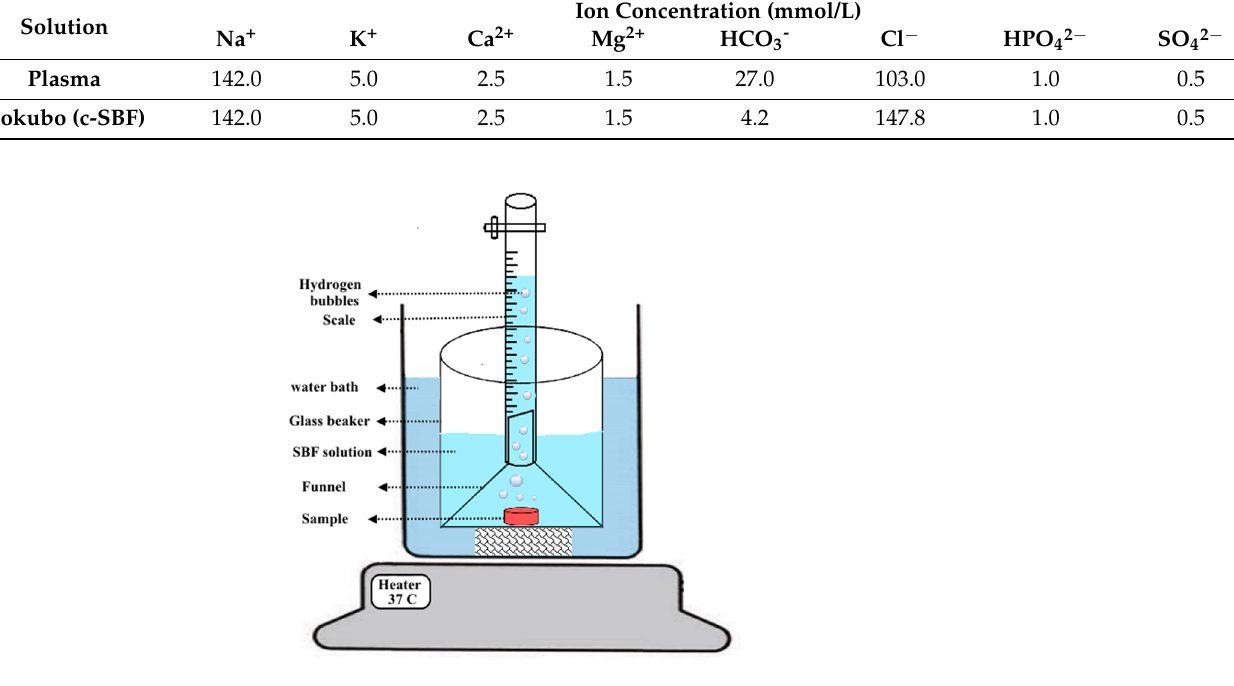
Figure 2. Schematic view of the hydrogen evolution measurement setup. Table 2. Chemical composition of the Kokubo simulated body fluid (SBF) compared to the human blood